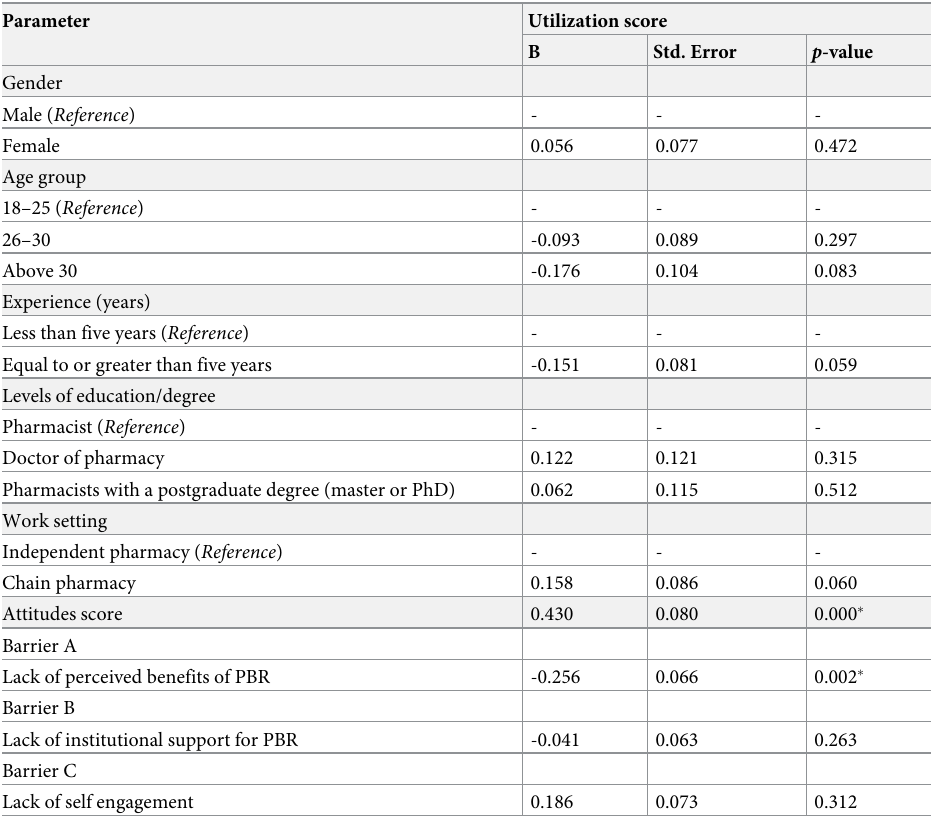
Table 5. Predictors of pharmacists’ utilization of current best evidence in their